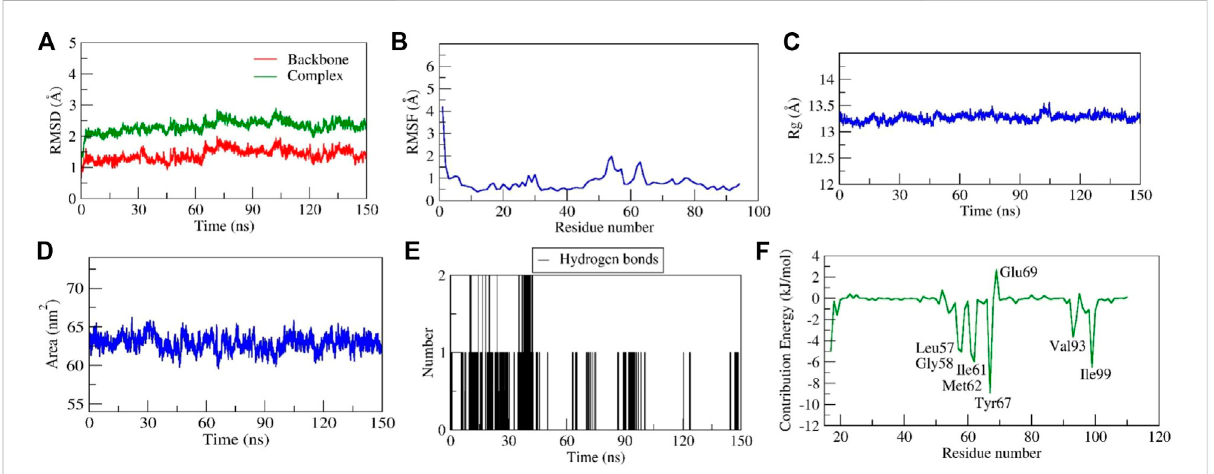
FIGURE 9 Parameters representingthestructuralstabilityoftheDiosgenin-MDM2 complex. (A) BackboneandcomplexRMSD, (B) RMSF, (C) Rg, (D) SASA, (E) number of H-bond interactions, and (F) contribution energy plot demonstrates the signi fi cance of the ligand binding domain residues in stable complex